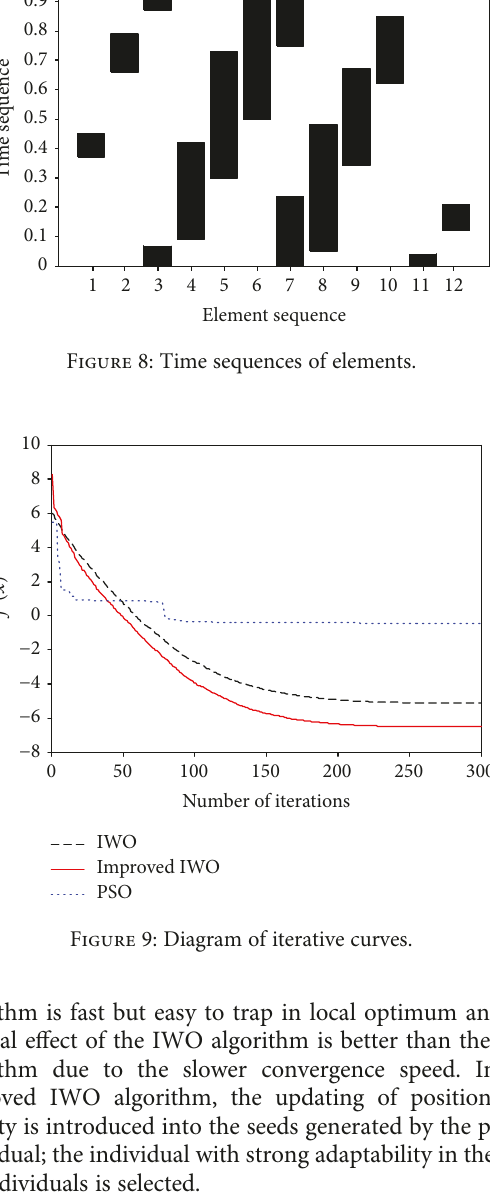
Table 5: The values of PSLL and f x .